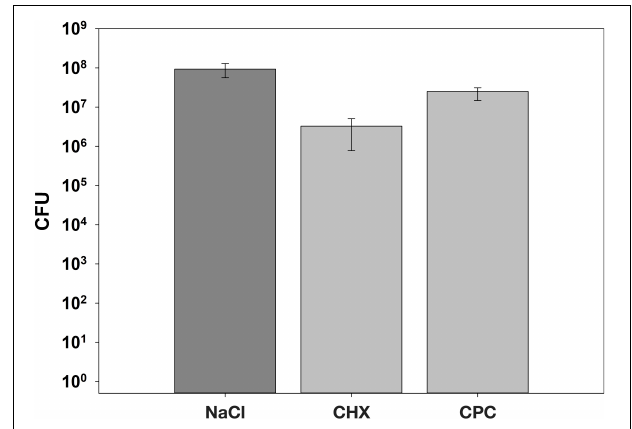
FIGURE 5 | The CFU results following two times daily treatment with either 0.9% NaCl, 0.1% CHX, or 0.05% CPC for a period of 7 days. All results are depicted as medians, 1st and 3rd quartiles from eight individual biological replicates on a log 10 -scaled